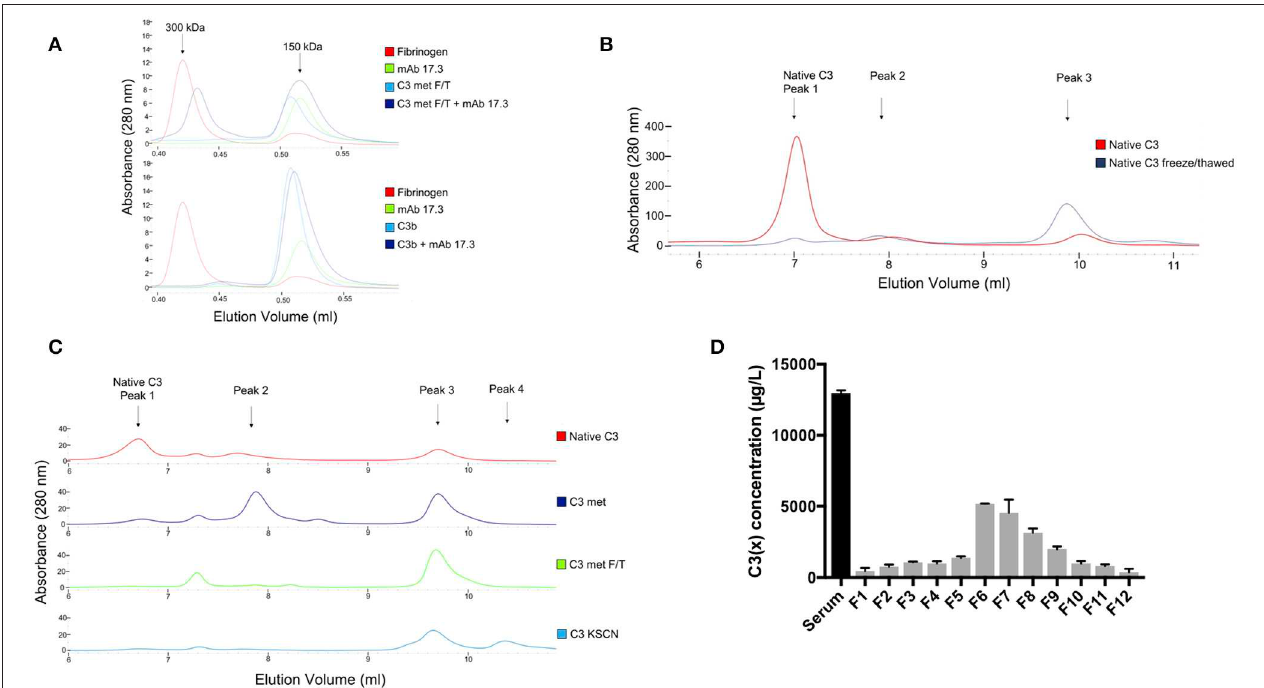
FIGURE 3 | (A) SEC analysis of complexes formed between anti-C3a mAb 4SD17.3 and F/T C3 (upper panel) and C3b (lower panel). Fibrinogen with a molecular weight of ca 300 kDa was used as a molecular weight marker with approximately the same size as formed complexes. (B) MonoS cation exchange chromatography analysis of native C3 (red line) and C3 after repeated F/T (blue line). (C) The corresponding MonoS analysis of native C3 (red line), methylamine treated C3 (darkblue line), methylamine treated C3 after repeated F/T (green line) and KSCN treated C3 (lightblue line). The identified main peaks are marked in the chromatogram. (D) C3(x) ELISA for identification of C3(x) in the fractions containing C3 collected from MonoS cation exchange chromatography separation of human serum sample after incubation at 37 ◦ Cover night (24h). The serum sample was precipitated with PEG 4000 prior to application on the